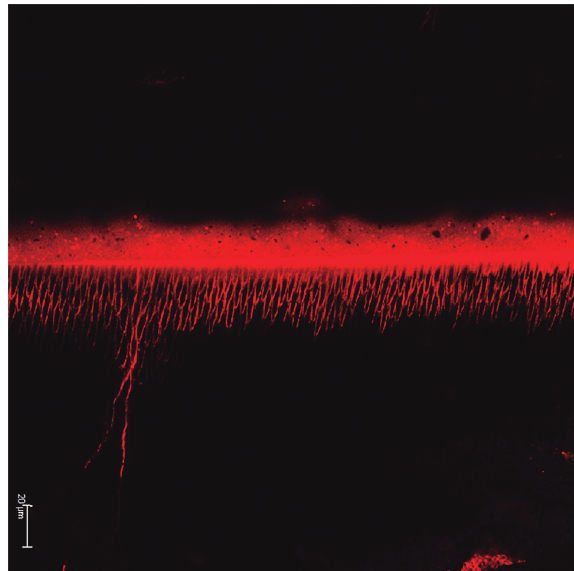
Figure 7b- Interface aspect of bonding system to enamel surface eroded by Zero Coke (ZC) followed by toothbrushing. Hybrid layer is not affected as in the control group